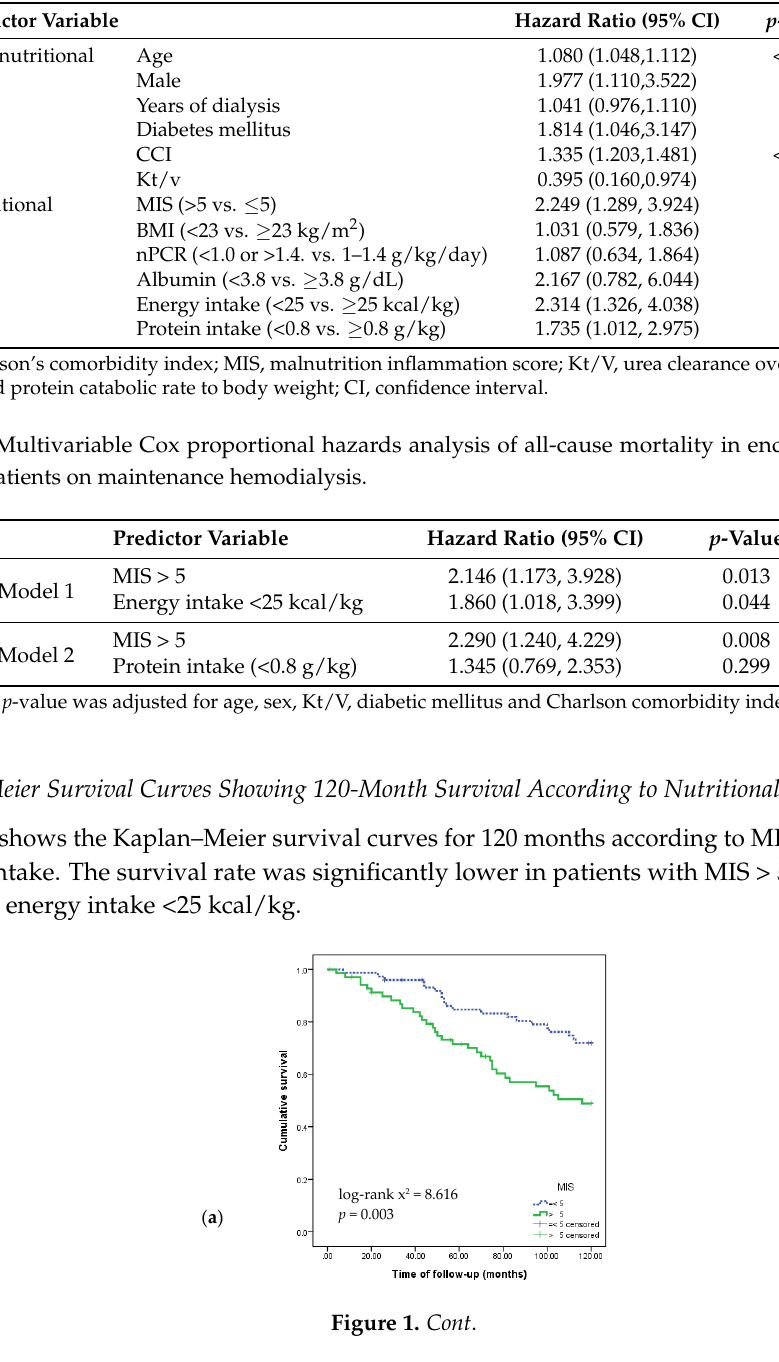
Table 5. Univariate Cox proportional hazards analysis of all-cause mortality in end-stage renal disease patients on maintenance hemodialysis.